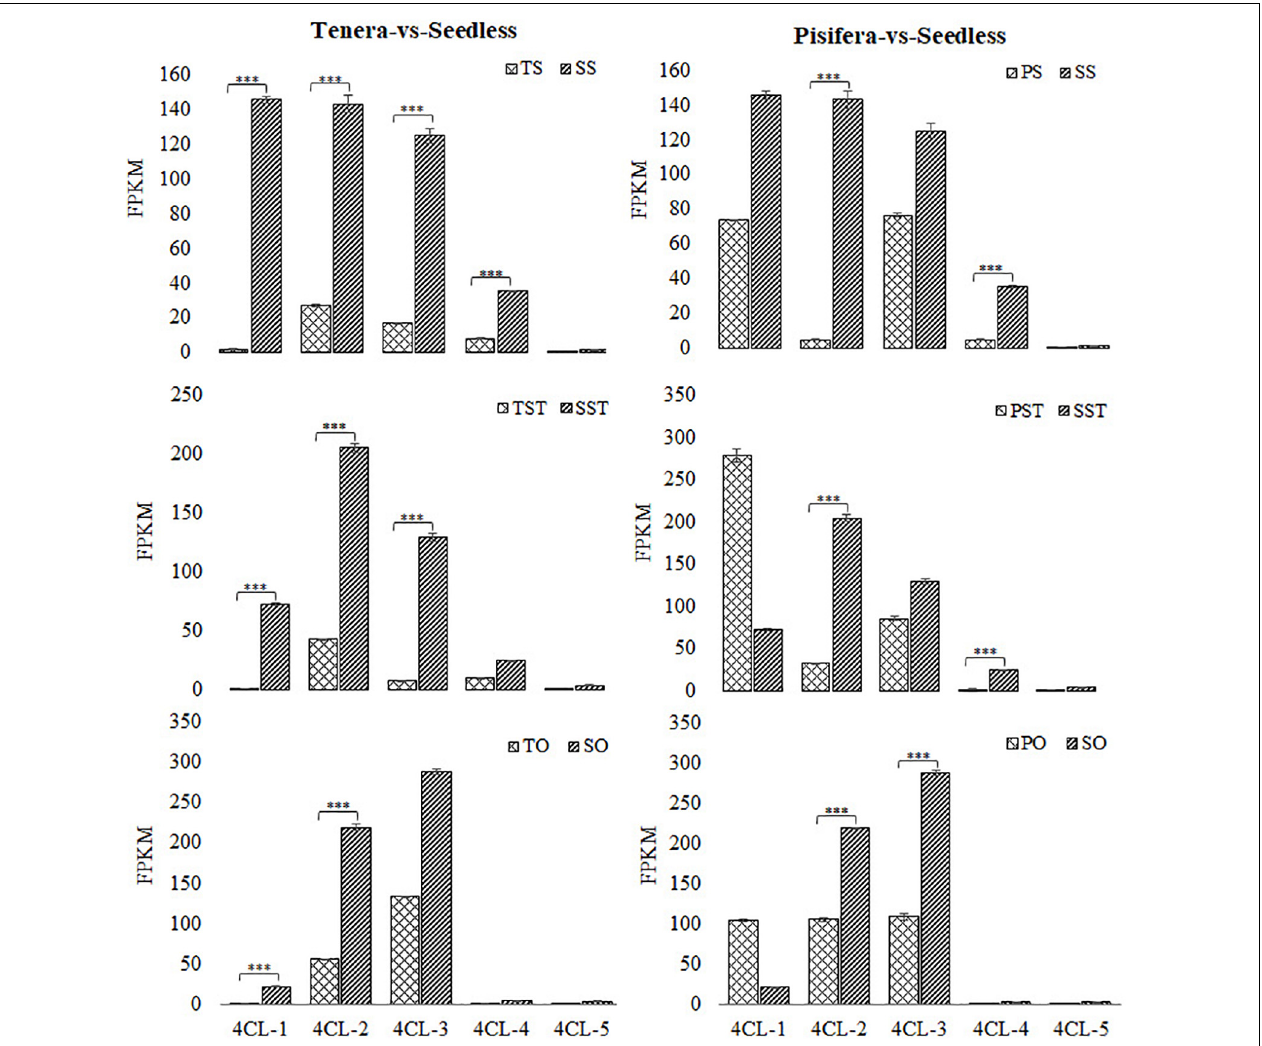
FIGURE 4 | Expression changes of 4-coumarate-CoA ligase (4CL) in Seedless palm trees compared with Tenera and Pisifera in various floral tissues (S, stigma; ST, style; O, ovary). Values shown are means ± SD from three replicates, and asterisks ( ∗∗∗ P ≤ 0.001) indicate a significant difference according to the Student’s t -test.